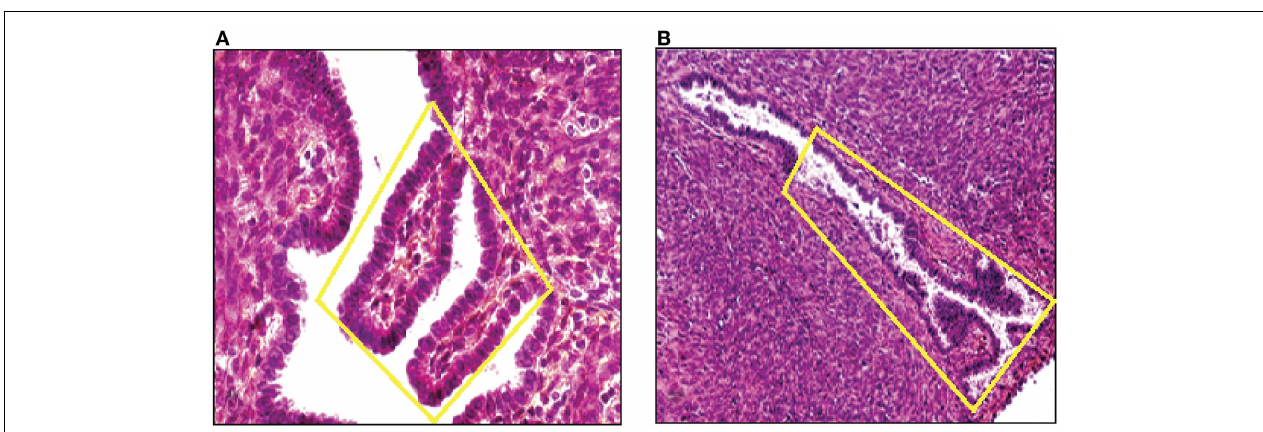
FIGURE 5 | DNA was extracted from a tissue section of a large peritoneal endometriotic implant with presence of an endometriotic gland containing papillary projections [Hematoxylin Eozin stained (A), and from a gland of tissue section from rectovaginal endometriotic nodule (B)] .